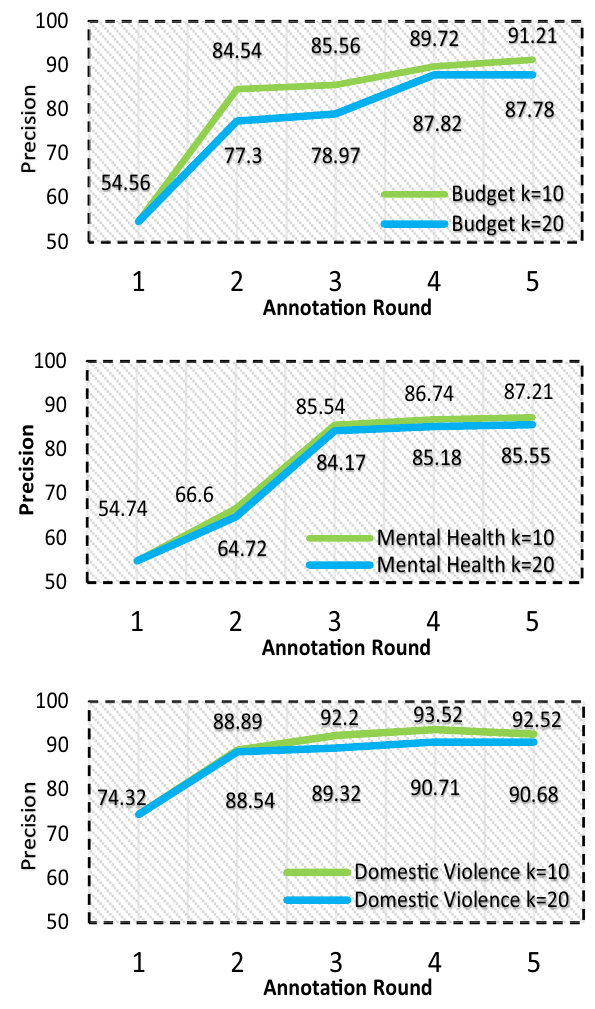
Fig. 5 The performance of a Bayesian multi-armed-bandit algorithm in adapting rules. As presented the algorithm could improve rules precision in all domains